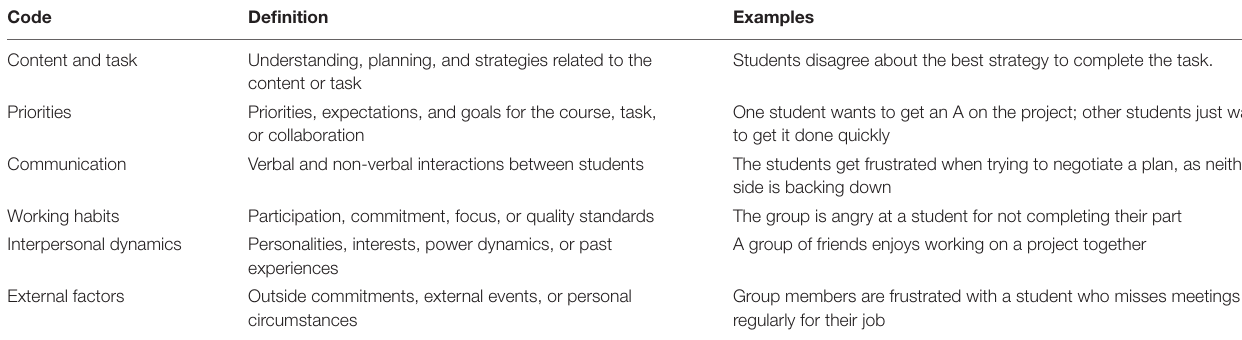
TABLE 3 | Stimulus events